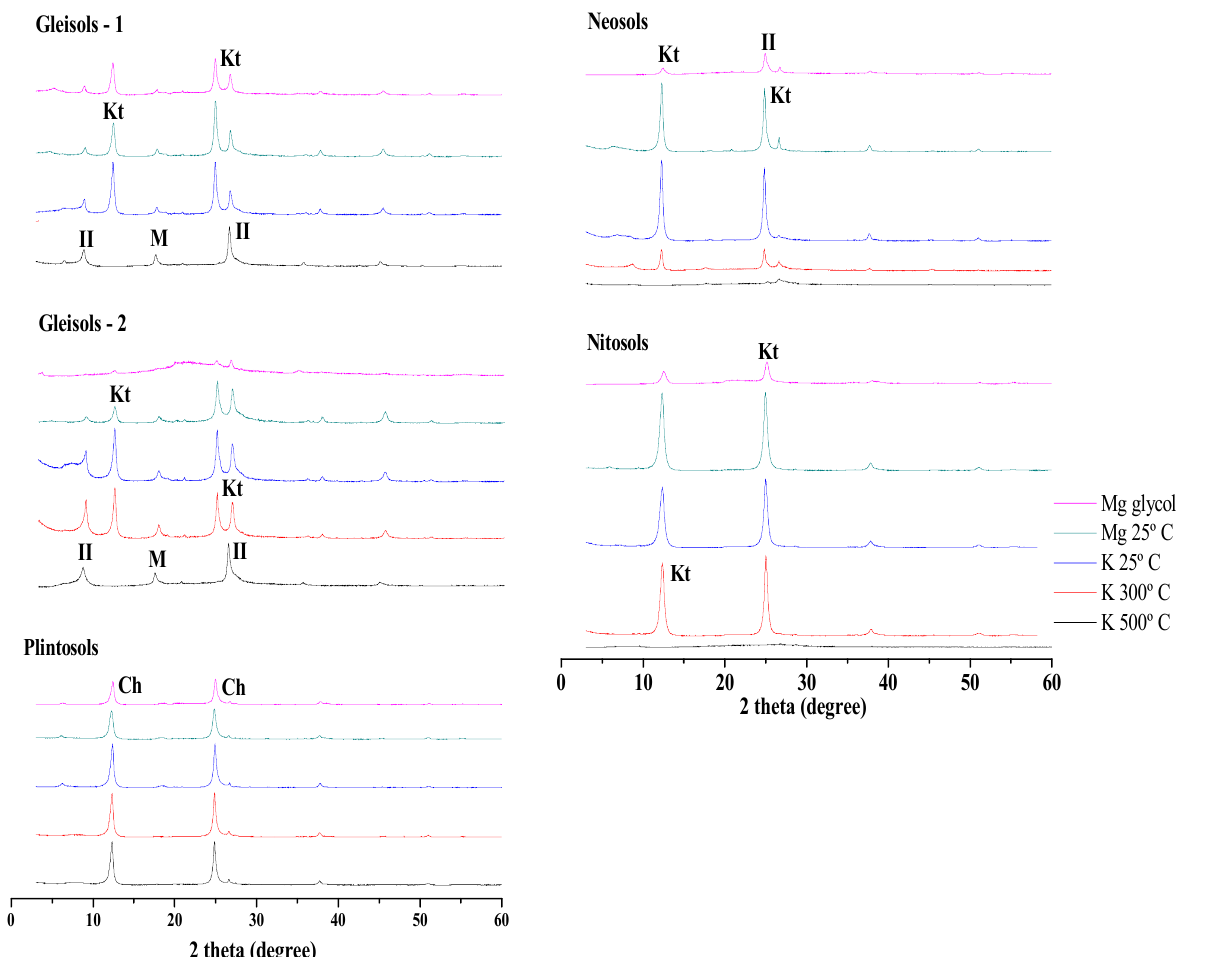
Figure 9. X-ray diffractograms in Gleisols, Plintosols, Neosols, and Nitosols of the state of Pará.